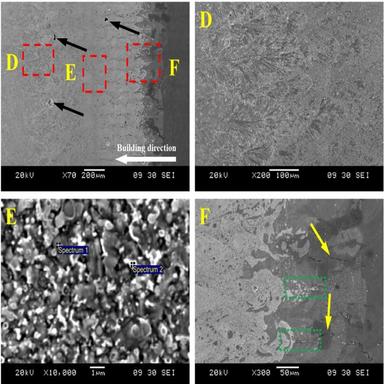
High magnification microstructure at the L/C interface after etching.